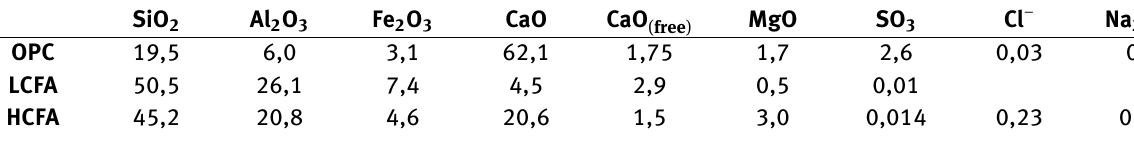
Table 1: Chemical composition of Portland cement clinker and fly ashes [%].